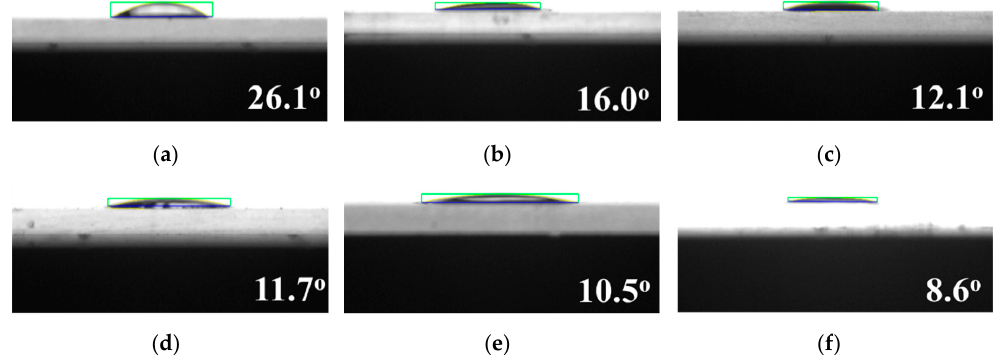
Figure 1. Contact angle of the functional coating film according to the annealing gas; ( a ) is naturally dried, ( b – f ) are annealed with H 2 , N 2 , Ar, O 2 , and in a vacuum, respectively.